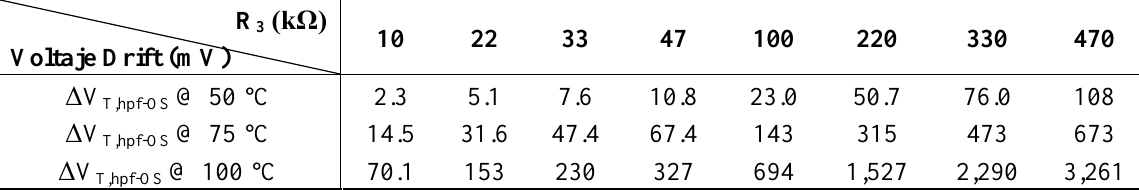
Table 10. Output voltage drifts ΔV